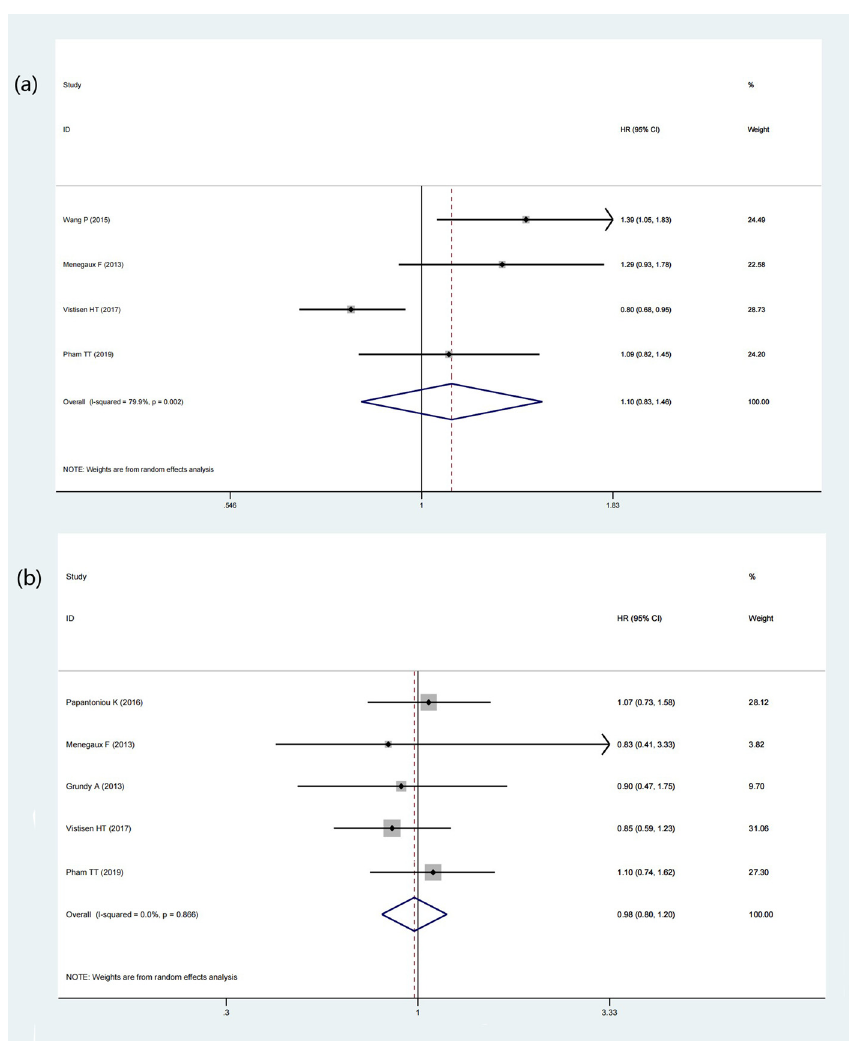
Figure 6: Forest plot depicting the association between night shift work and risk of receptor negative BC. ( a ) HER2 − BC. ( b ) ER − /PR −